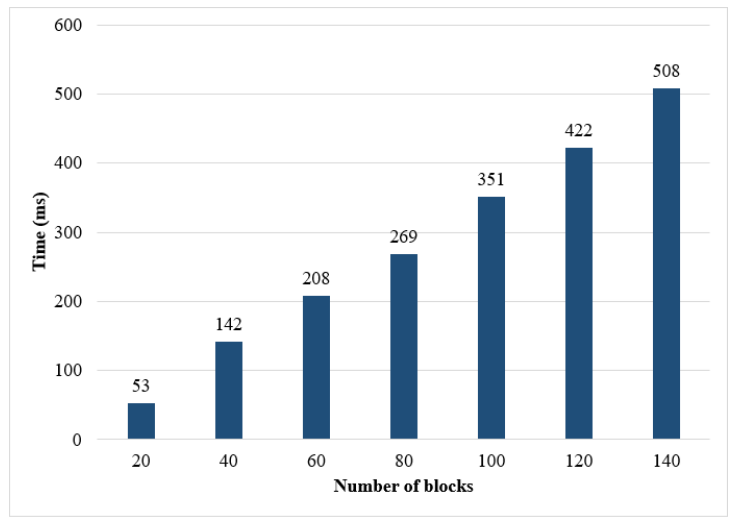
Figure 5. Block processing